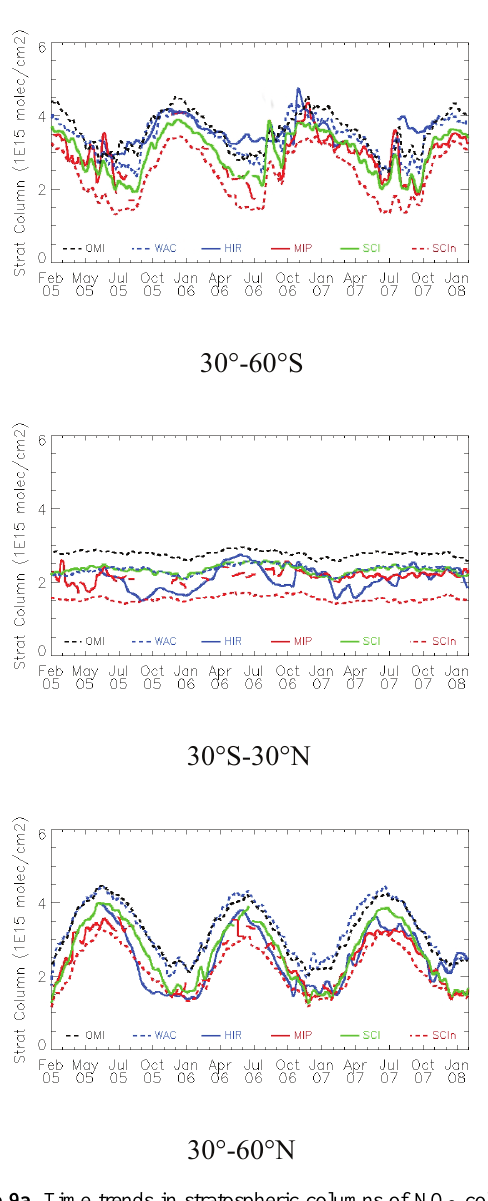
Figure 9a. Time trends in stratospheric columns of NO 2 columns (SH in top panel, tropics in middle panel, NH in bottom panel) from SCIAMACHY limb (green), MIPAS (red), HIRDLS (blue), WACCM (dashed blue), SCIAMACHY nadir (dashed red) and OMI (dashed black) integrated down to